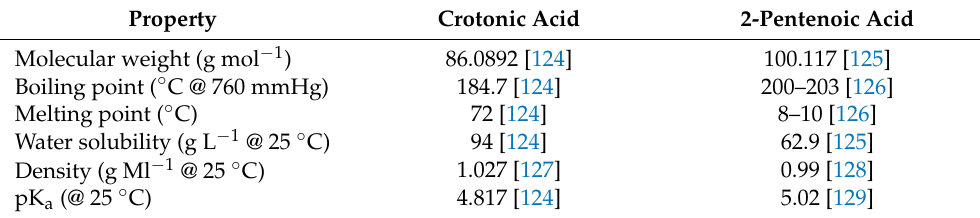
Table 4. Properties of crotonic acid and 2-pentenoic